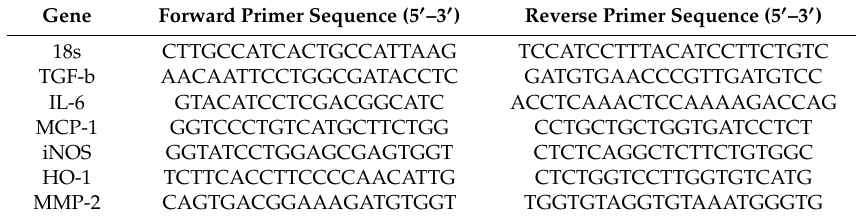
Table 1. Primer sequences. 18s: housekeeping gene 18s; TGF- β : transforming growth factor beta 1; IL-6: Interleukin-6; MCP-1: monocyte chemoattractant protein 1; iNOS: inducible nitric oxide synthase; HO-1: heme oxygenase; MMP-2: matrix metalloproteinase-2. Gene Forward Primer Sequence (5 (cid:48) –3 (cid:48)